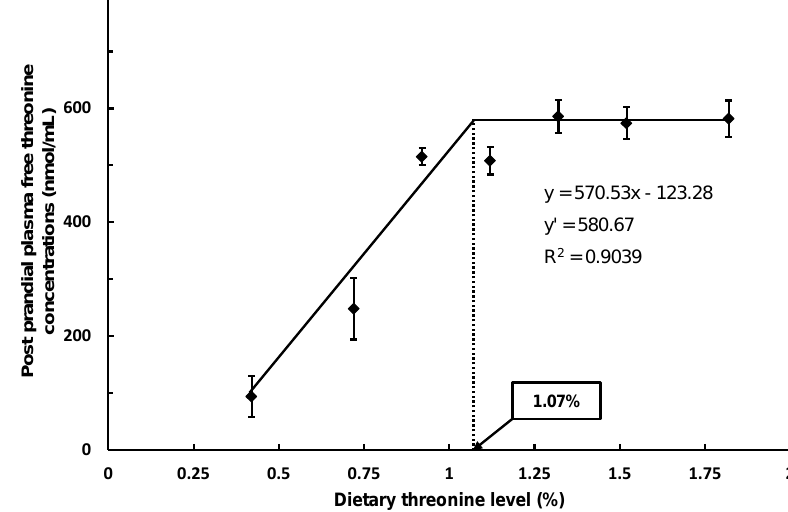
Figure 1. Broken line analysis of post-prandial plasma threonine concentrations (nmol/mL) in rainbow trout fed graded levels of dietary threonine. Values of the X-axis are the threonine levels in the experimental diets. Values are means±standard deviation of 5 replicates. Y = 570.53x–123.28, Y ' = 580.67, R 2 =